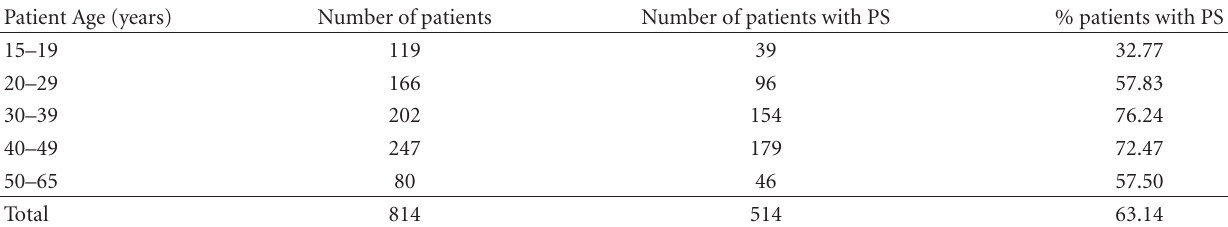
Table 1: Distribution pulp stone (PS) by